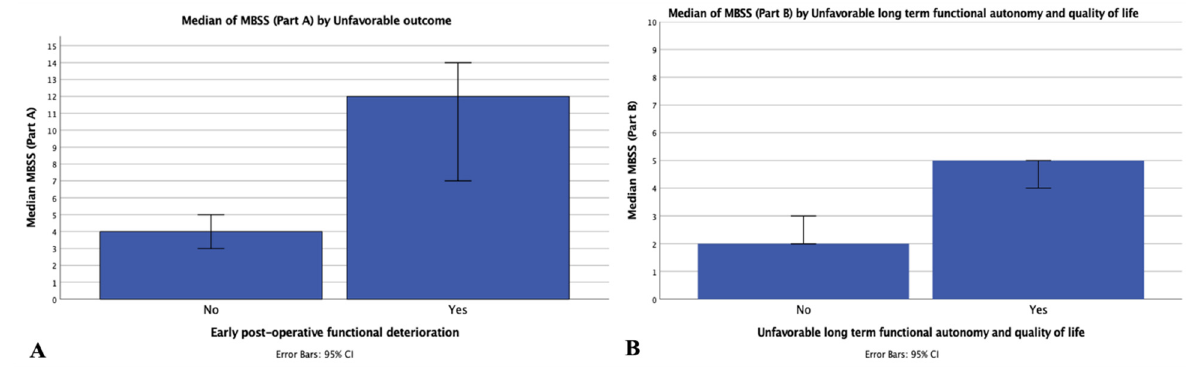
Figure 1. MBSS Part A and B by outcome subgroups. Histograms describe the distribution of MBSS subscores among those patients experiencing or not experiencing an early post-operative or long- term functional deterioration and reduced quality of life. ( A ) The histogram on the left represents the median MBSS Part A scores among those experiencing a decrease of at least 20 points in post- operative KPS or not compared with the pre-operative assessment. 95% CI errors bars are visualised. ( B ) The histogram on the right represents the median MBSS Part B scores among those experiencing a decrease of at least 20 points in follow-up KPS plus an overall quality of life measurement (FACT-Br overall score) under the 75th percentile of the population under exam or not compared with the pre-operative assessment. 95% CI error bars are visualised. MBSS: Milan Biometric-Surgical score; KPS: Karnofsky performance status; CI: confidence interval; FACT-Br: Functional Assessment of Cancer Therapy brain